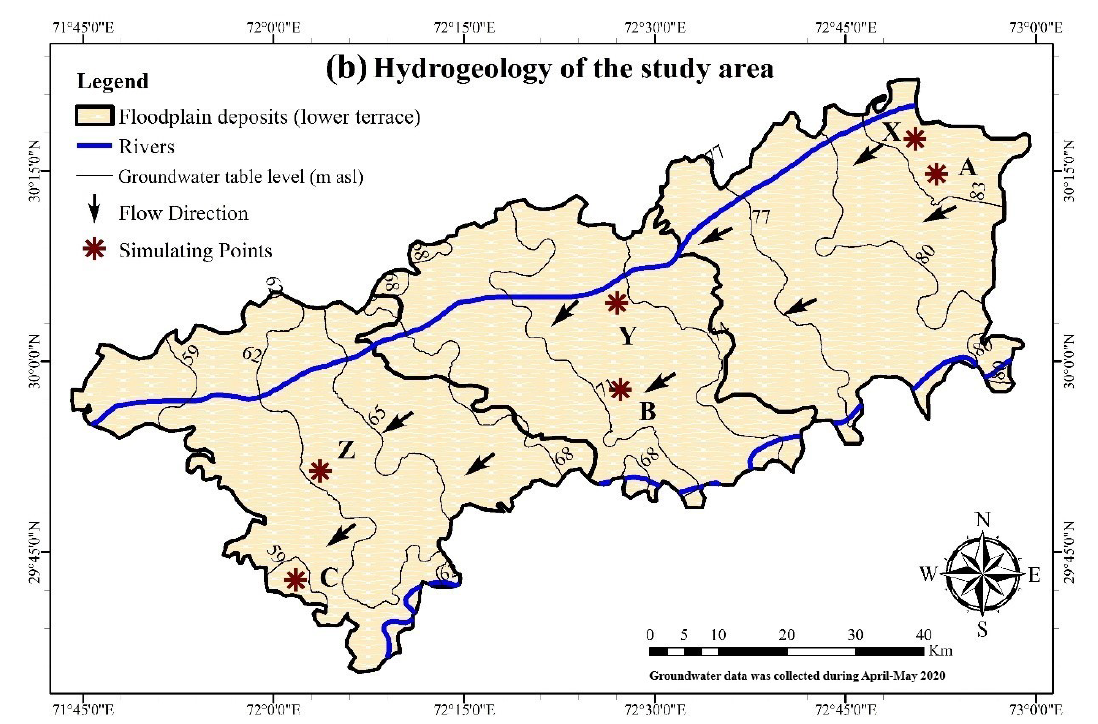
Figure 1. ( a ) Groundwater sampling points of the study area. ( b ) Flow and hydrogeology map.